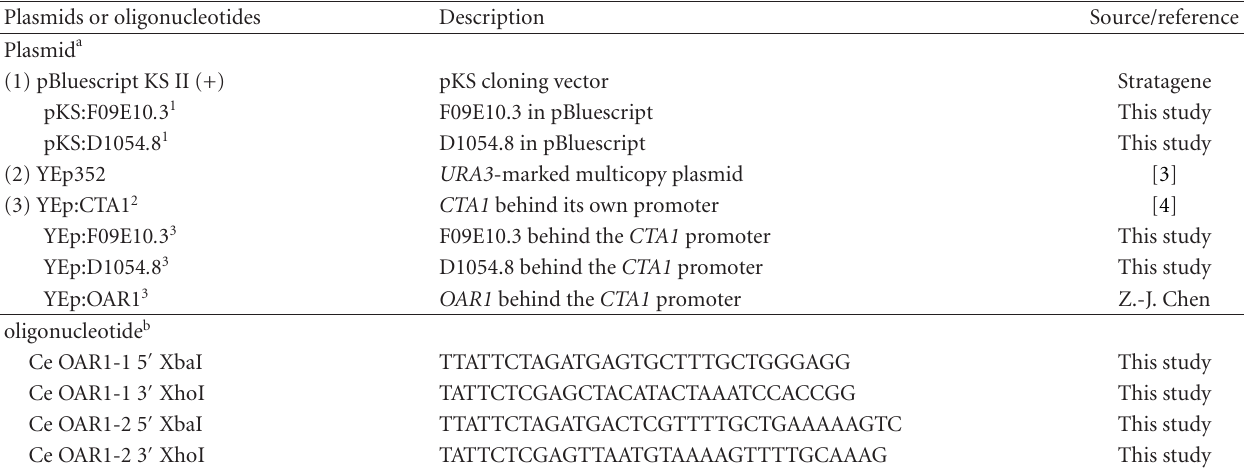
Table 1: Plasmids and oligonucleotides